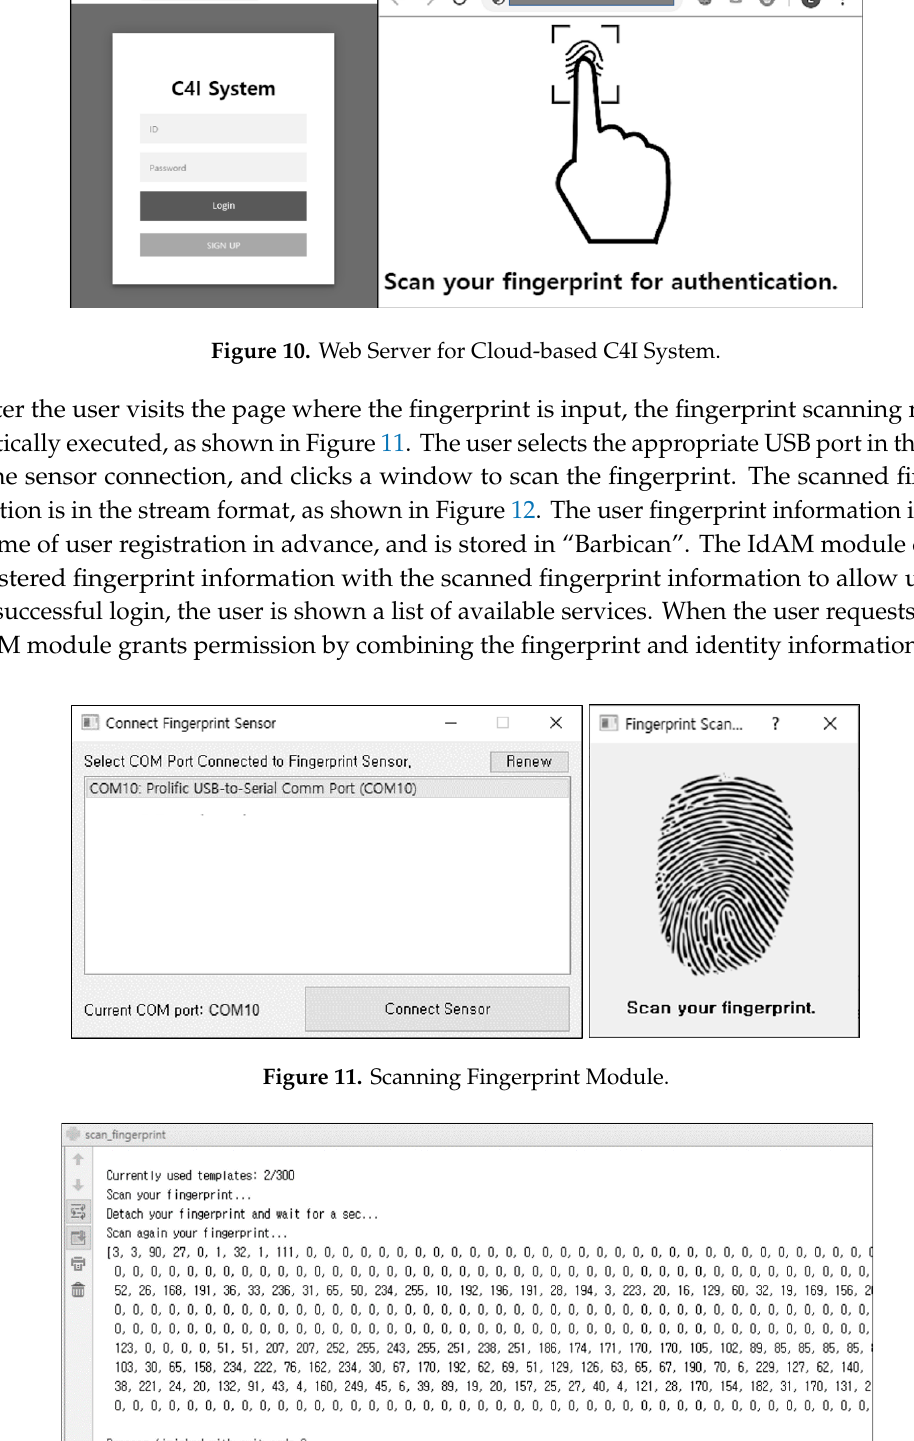
Figure 9. Fingerprint Scanning Sensor.